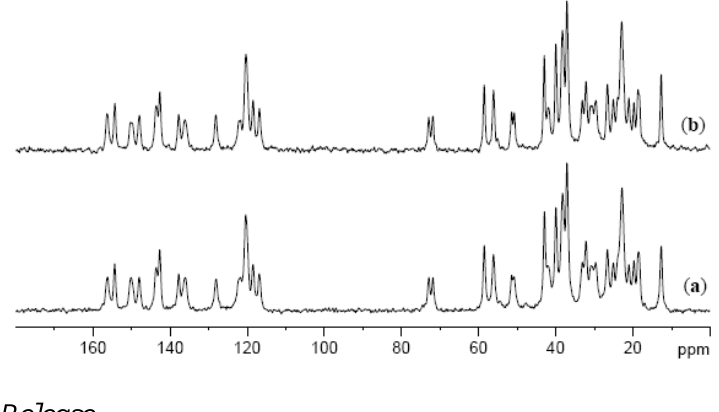
Figure 5. 13 C CPMAS NMR spectra of ( a ) xerogel of 3 from propan-1-ol; ( b ) xerogel of 3 and PC (1:1) from propan-1-ol.